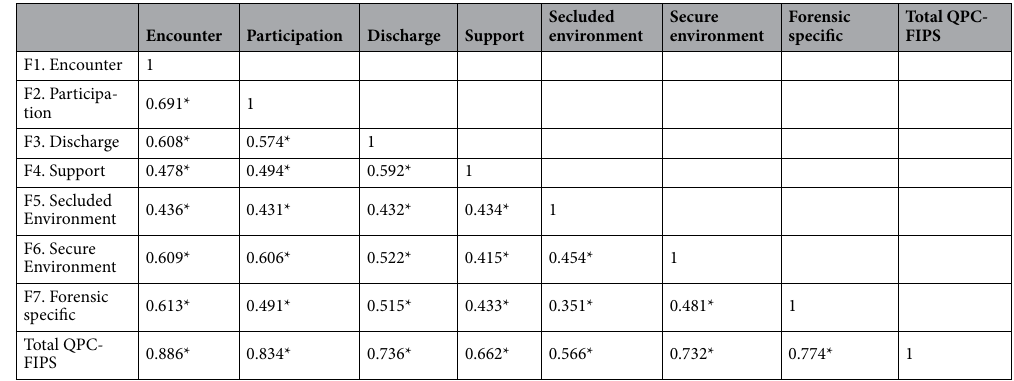
Table 2. Correlations among the subscales of the SPANISH QPC-FIPS. n = 153. *All correlation coefficients (rho) are significant at p ˂